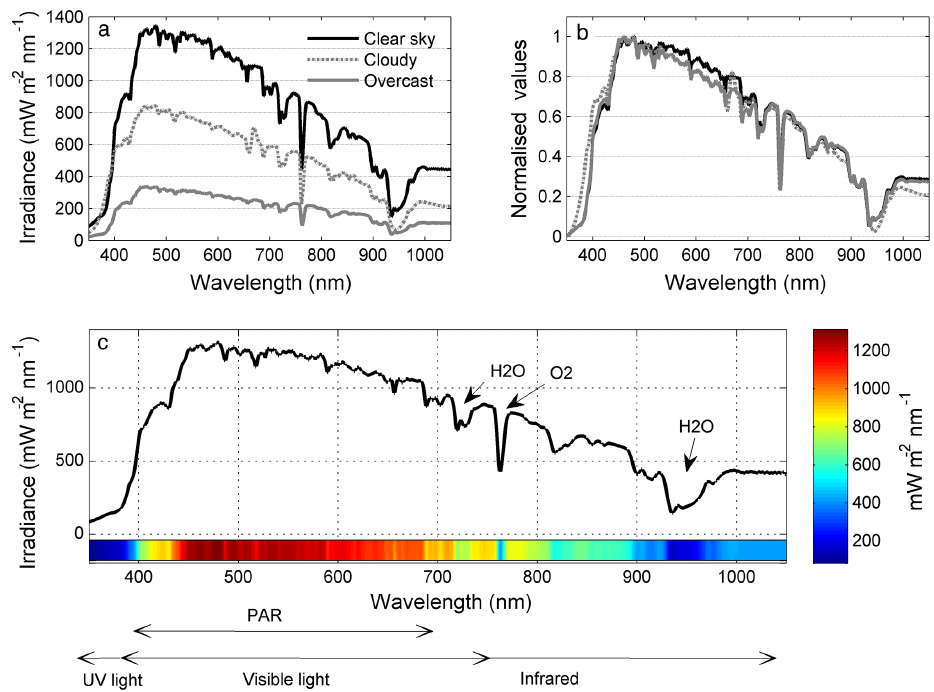
Figure 2. (a) Spectral distribution of solar radiation above the canopy for the three conditions, while (b) is the normalised data of the same data, showing the little variation according to sky condition and time of year. (c) Visualises the spectrum under clear sky, in addition to the colour-coded intensity. This visualisation should help to interpret the spectral distribution in Fig. 3. Furthermore, the main spectral features together with the wavelength distribution for the visible and PAR are